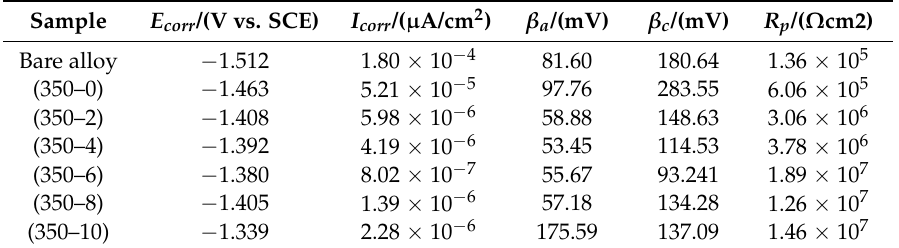
Table 3. Electrochemical parameters of bare alloy and MAO coatings specimens extracted from polarization test in 3.5 wt % NaCl.